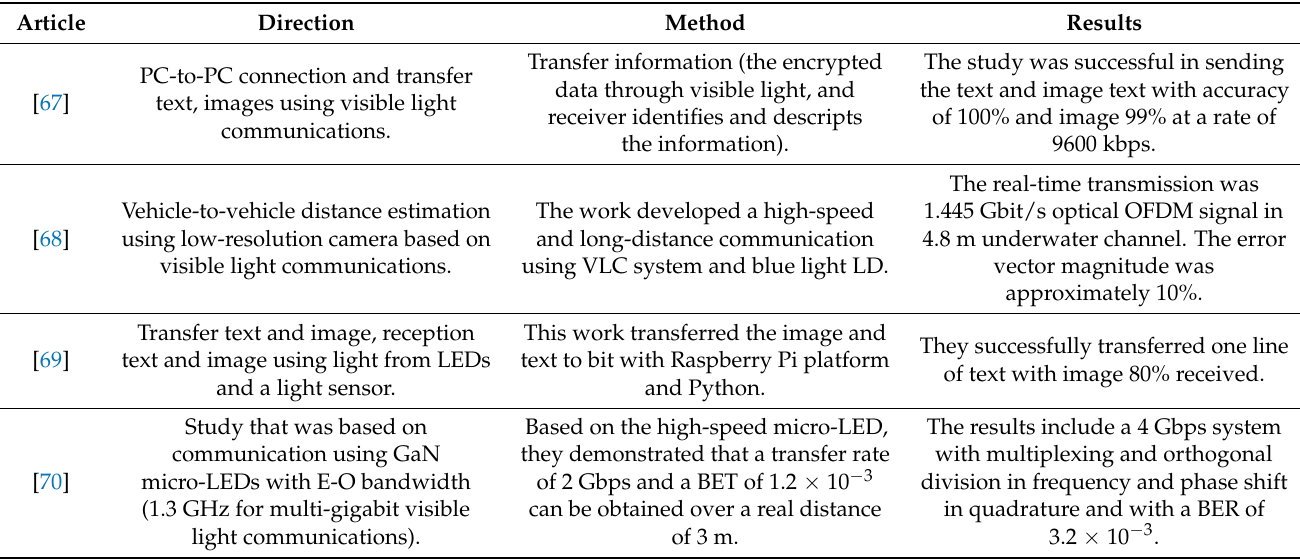
Table 3. Results obtained in the integration of mobile telephony in visible light